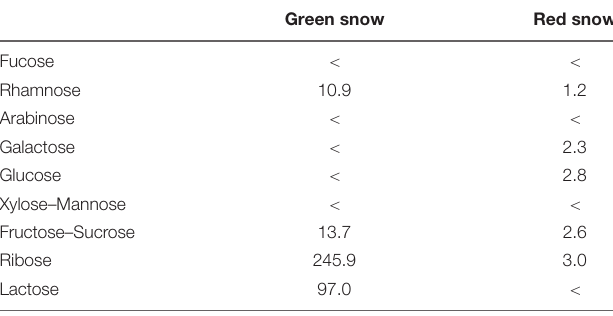
TABLE 7 | Free carbohydrate analyses, all compounds in µ g L − 1 . Green snow Red snow